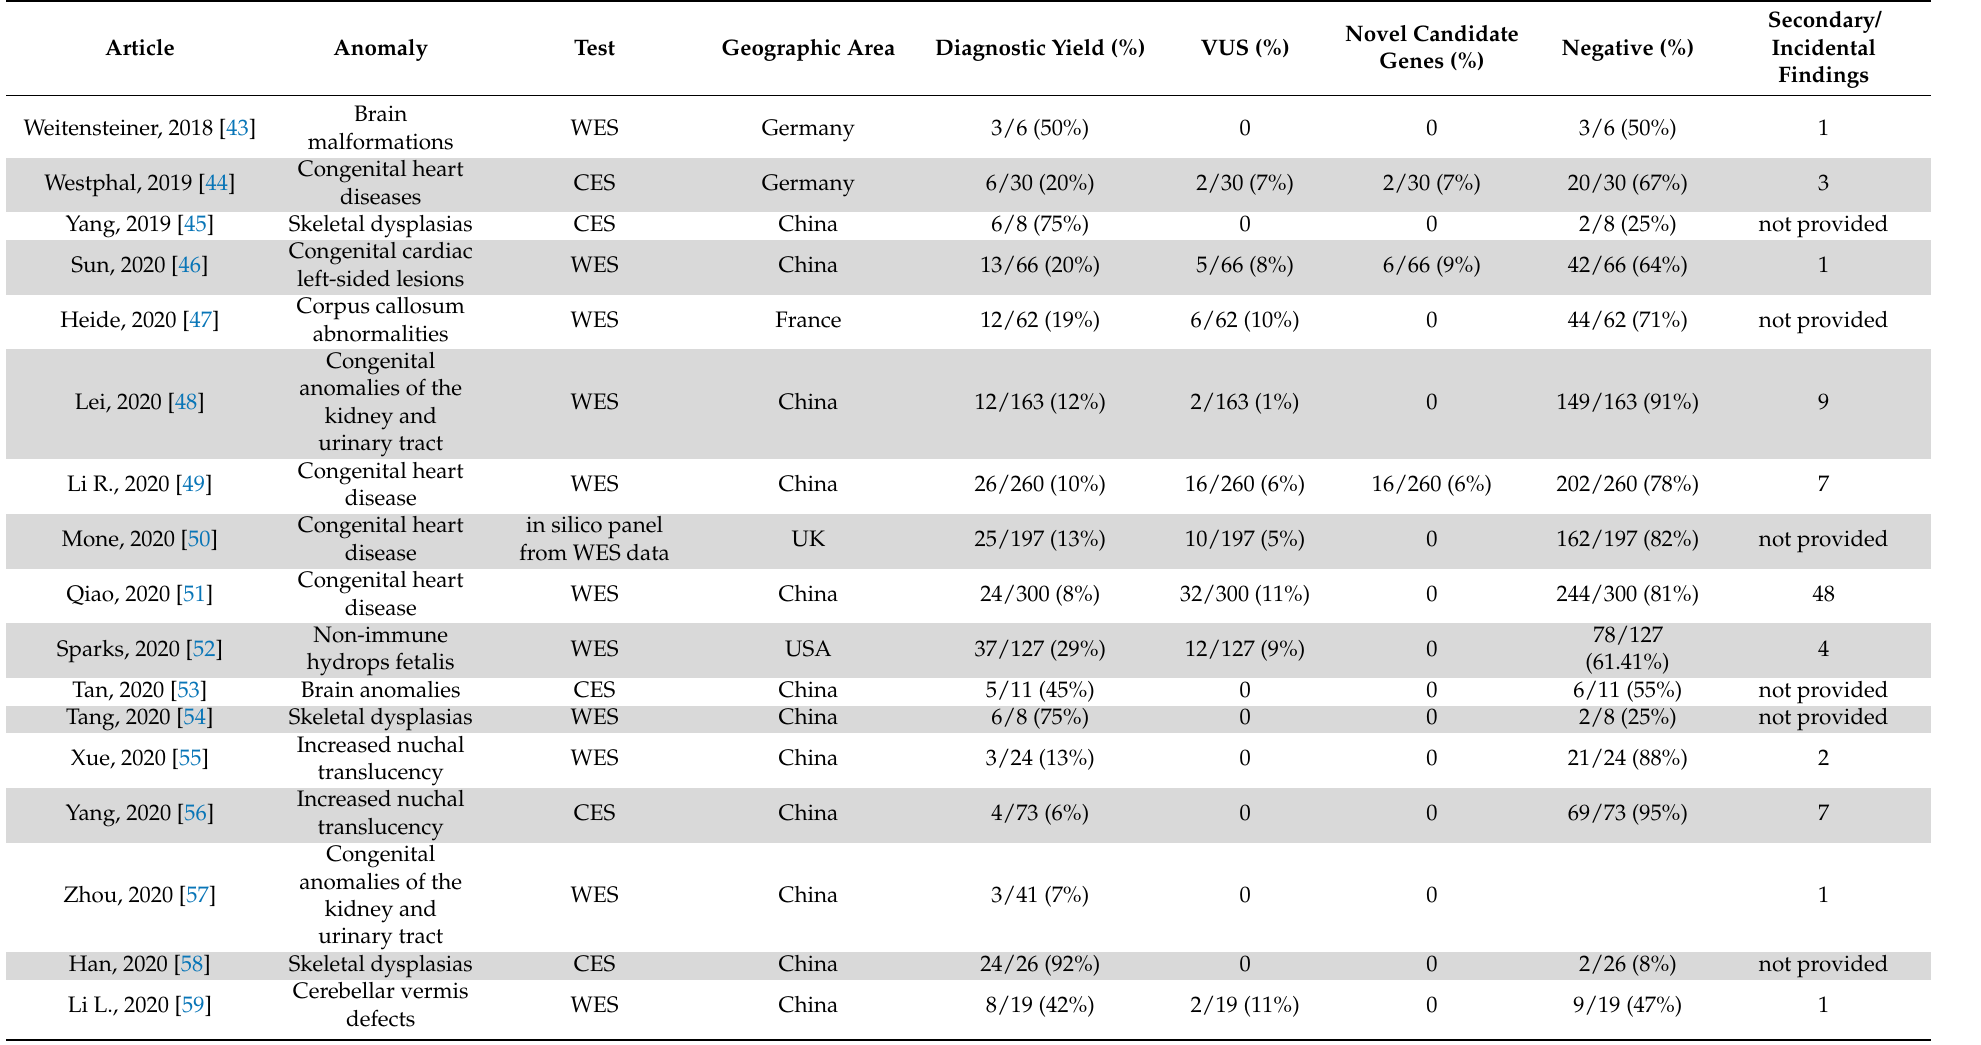
Table 2. pES in fetuses selected for specific class